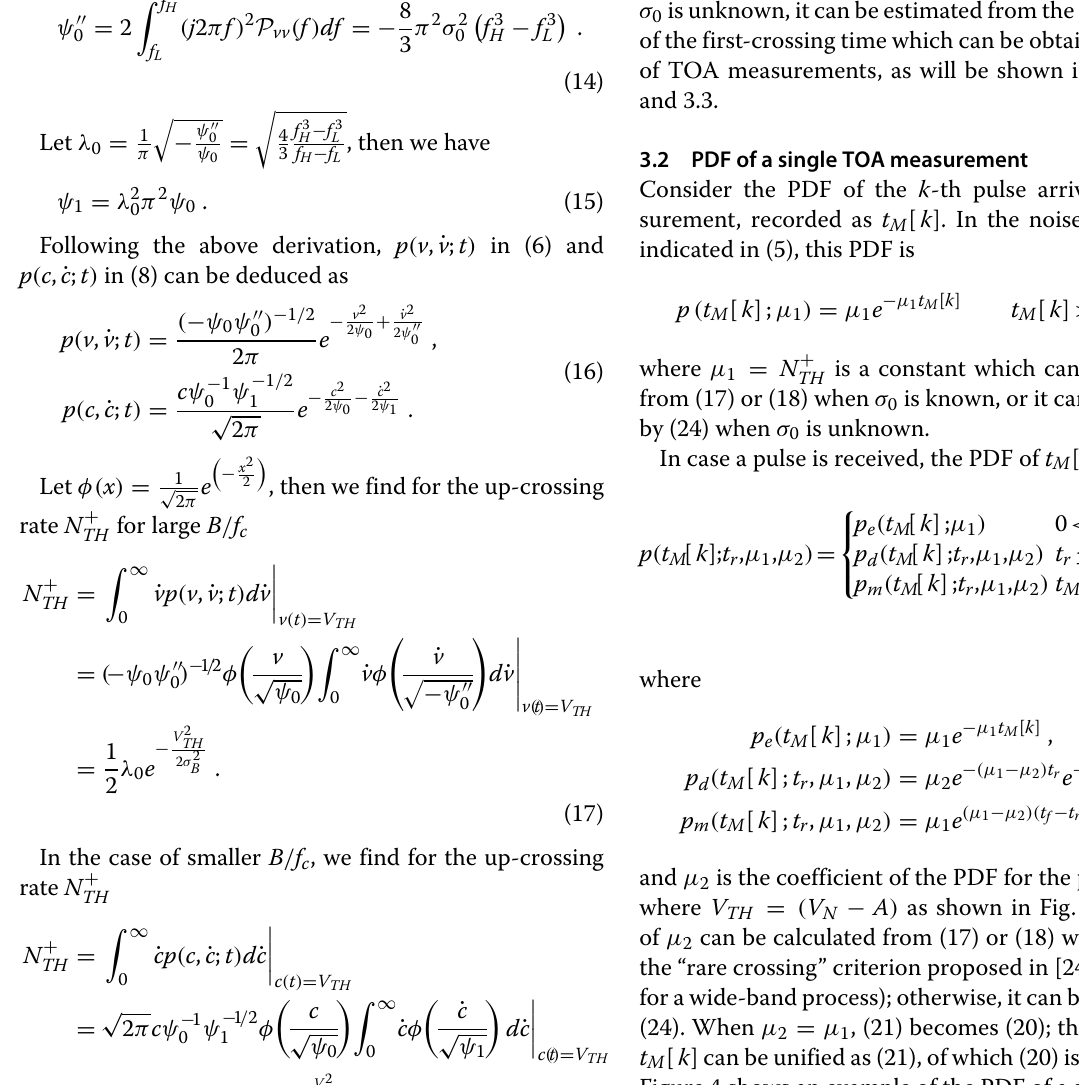
measurements. Figure 4a is obtained under the condition of f L = 3.1 GHz, f H = 6.1 GHz, V N /σ B = 1.7, where the horizontal axes indicates the measured TOA, and Fig.4b is obtained when the FP arrives at t r = 2 ns with a first- peak-to-noise-ratio (FPNR) of FPNR = 0.5 dB based on the noise floor in Fig. 4a, where FPNR = 10 log